Question: Looking at the figure, what chart type is it?
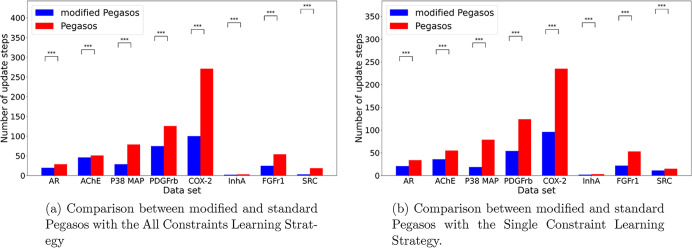
Answer: bar